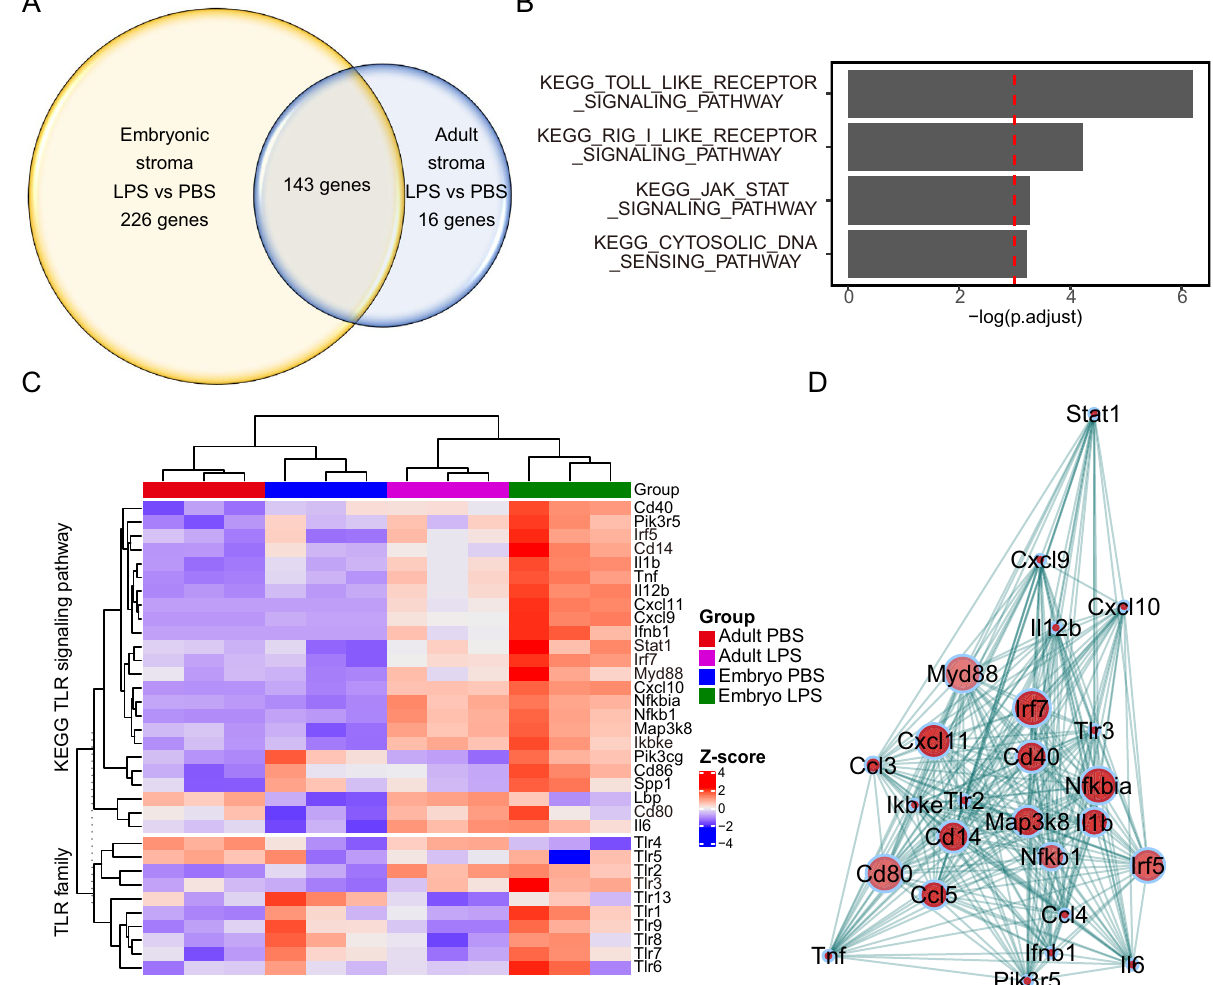
Figure 2. Identification of key genes differentially expressed by the immature mouse intestinal stroma upon inflammatory stimulation ex vivo. ( A ) Venn diagram showing the number of differentially expressed genes (DEGs) in primary adult or embryonic intestinal stromal cells treated with LPS in comparison to vehicle controls. 3 independent cultures generated from 3 adult mice or 6 pooled embryos/culture were sequenced. DEG had absolute value of log2 fold change ≥ 2.0, FDR < 0.05. ( B ) Significantly enriched KEGG pathways for 226 genes differentially expressed in LPS stimulated embryonic stromal cells. FDR < 0.05. ( C ) Heatmap generated using ComplexHeatmap R package version 2.1.0 27 depicting unsupervised clustering of TLR and TLR pathway component expression in LPS or control vehicle treated embryonic and adult stromal cells ex vivo. ( D ) Network visualization constructed using R package WGCNA 28 of the correlation between DEG in LPS stimulated embryonic stromal cells in the KEGG TLR signaling pathway. Each dot represents a gene, dot interior colour denotes upregulation (red) of gene transcript in LPS treated cells compared to PBS treated cells, dot size indicates the magnitude of gene expression correlation to neighboring genes, lines connecting dots represent topological